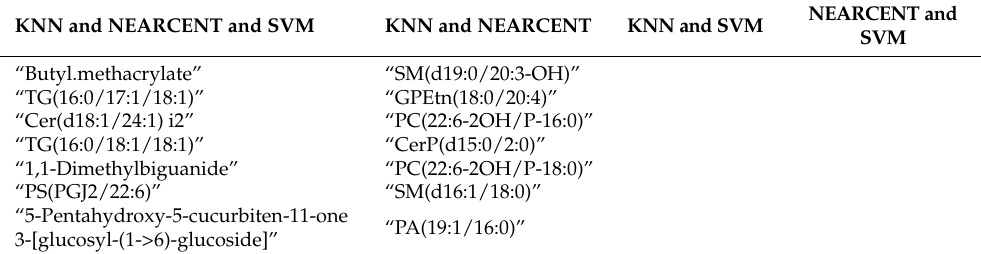
NEARCENT and SVM